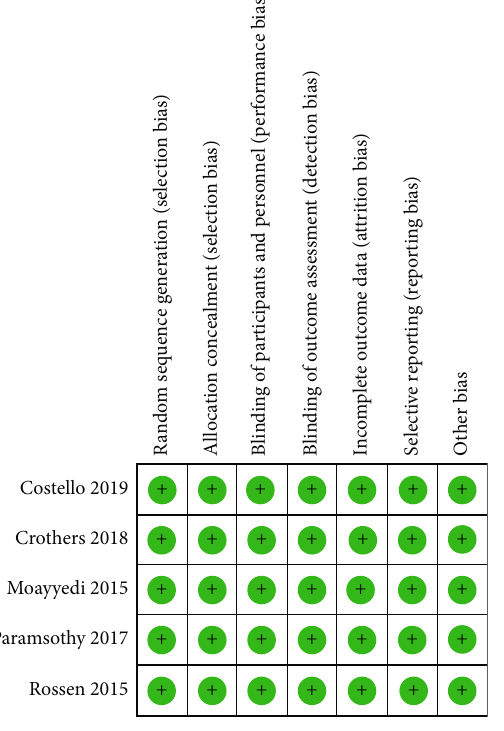
Figure 2: Risk of bias of included